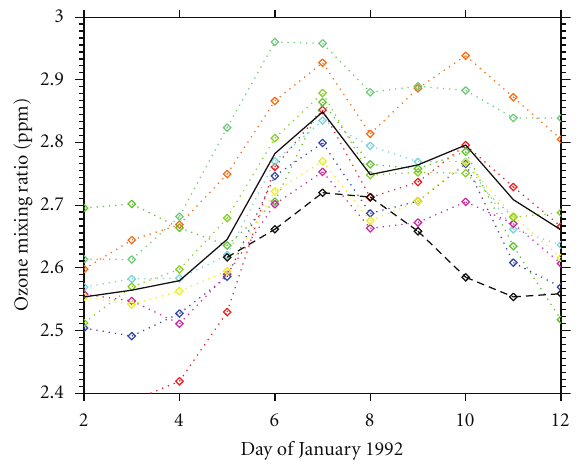
Figure 5: Zonal mean ozone volume mixing ratio (ppmv) at 48km averaged over 40 ◦ N–50 ◦ N from HALOE data (dotted black line) and from the model results. The ensemble mean is shown by solid black line; color lines represent di ff erent ensemble